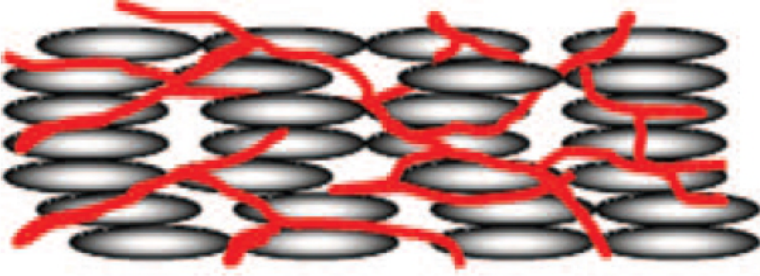
Figure 4. Schematic of a polymer stabilized liquid crystal. The polymer network acts as a template of the self-organised liquid crystalline phase that it was formed